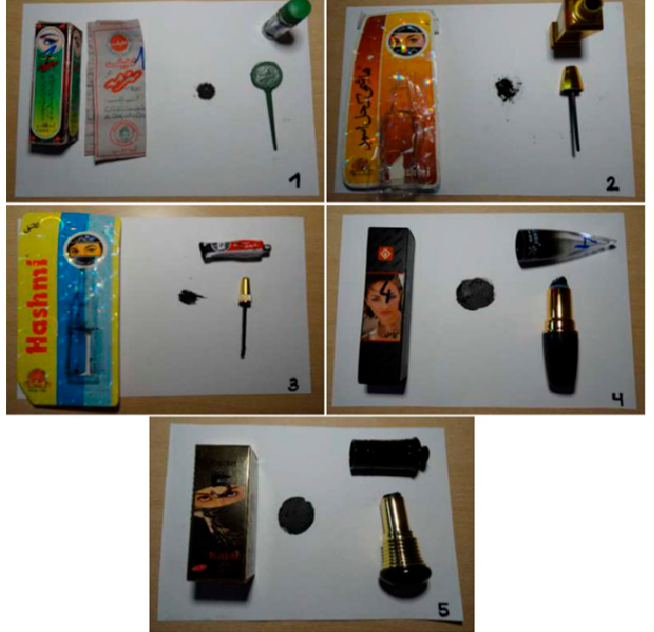
Figure 1. Images of kohl-based eyeliners in powder ( 1 and 2 ), paste ( 3 ), and pencil ( 4 and 5 ) evaluated in this study. Product labeling included cosmetic characteristics, ingredients, mode of use, application dose, precautions, and data of the person responsible. Product labeling indicated that Pb content was